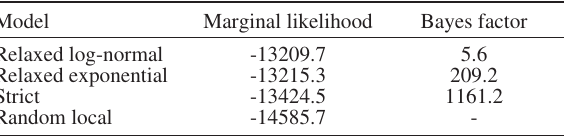
Table S2. – Results from the molecular clock model